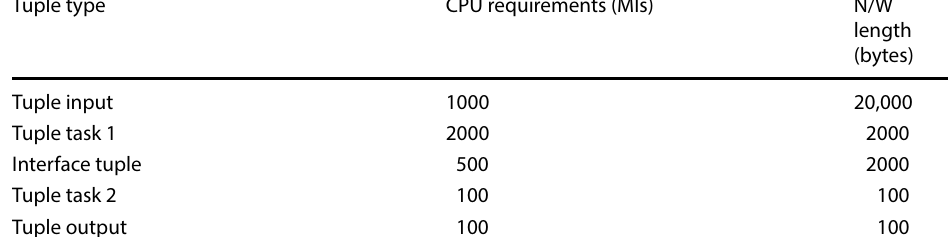
Table 2 The simulation